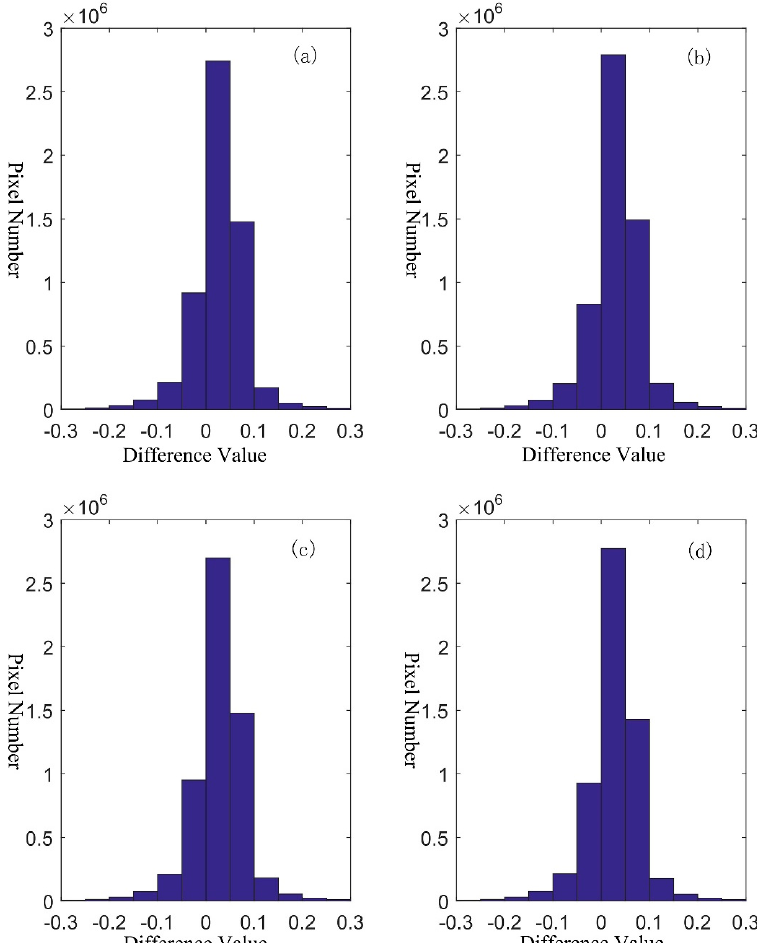
Figure 8. Histograms of differences between the FVC estimated from the four machine learning methods and the GLASS FVC: ( a ) BPNNs; ( b ) GRNNs; ( c ) MARS; and ( d ) GPR.